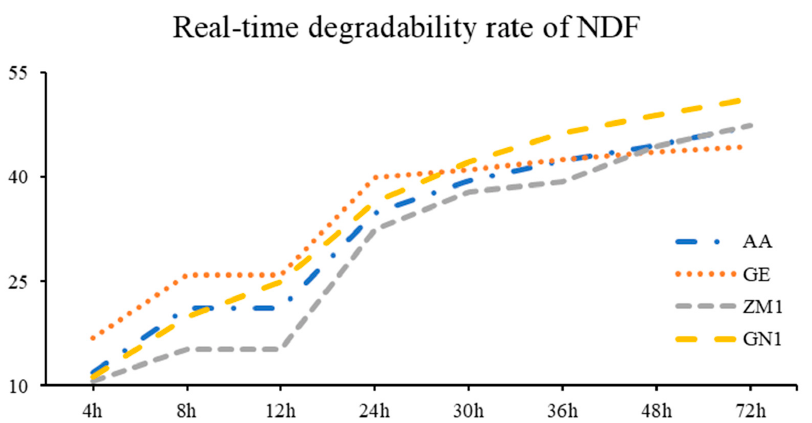
Figure 3. The real-time degradability rate of NDF in different alfalfa hay cultivars. AA: American